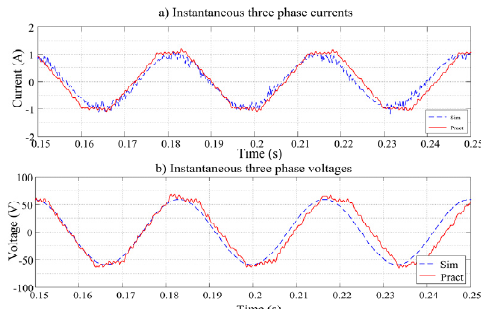
Figure 22. Simulation vs. Practical implementation 3phase currents and voltages.